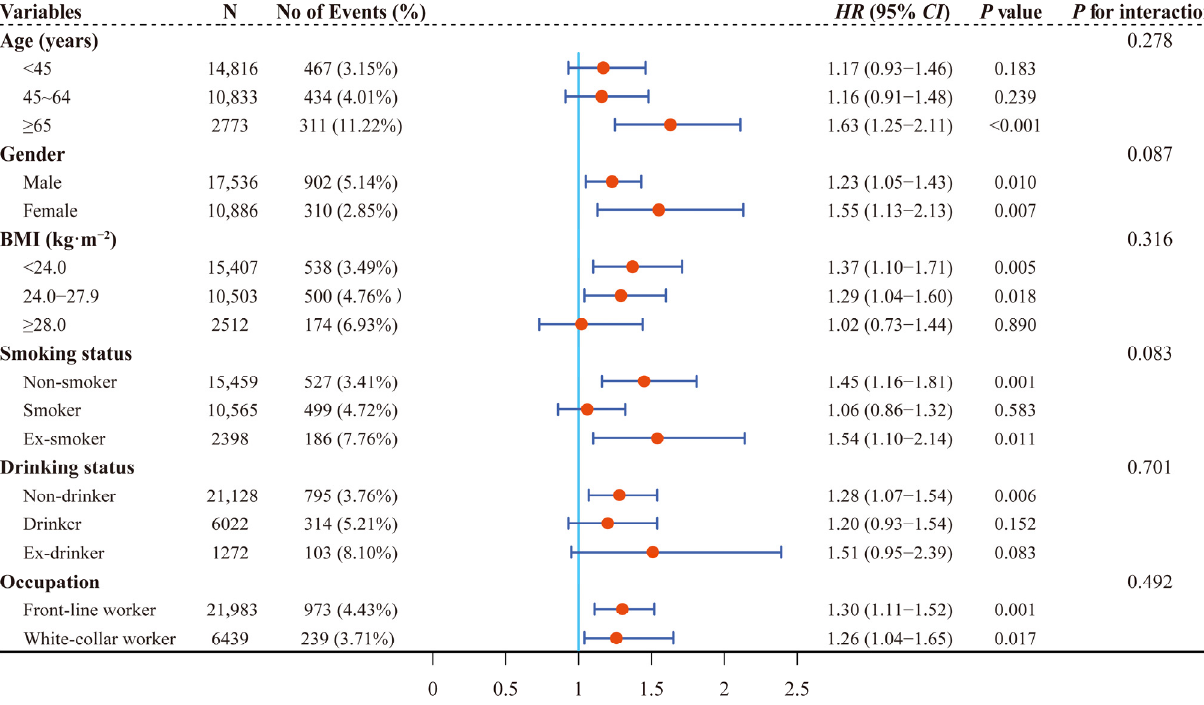
Figure 4. Stratified associations between HUA and new-onset CKD by age, gender, BMI, smoking status, drinking status, and occupation. HUA, hyperuricemia; CKD, chronic kidney disease; BMI, body mass index; HR, hazard ratio; CI, confidence